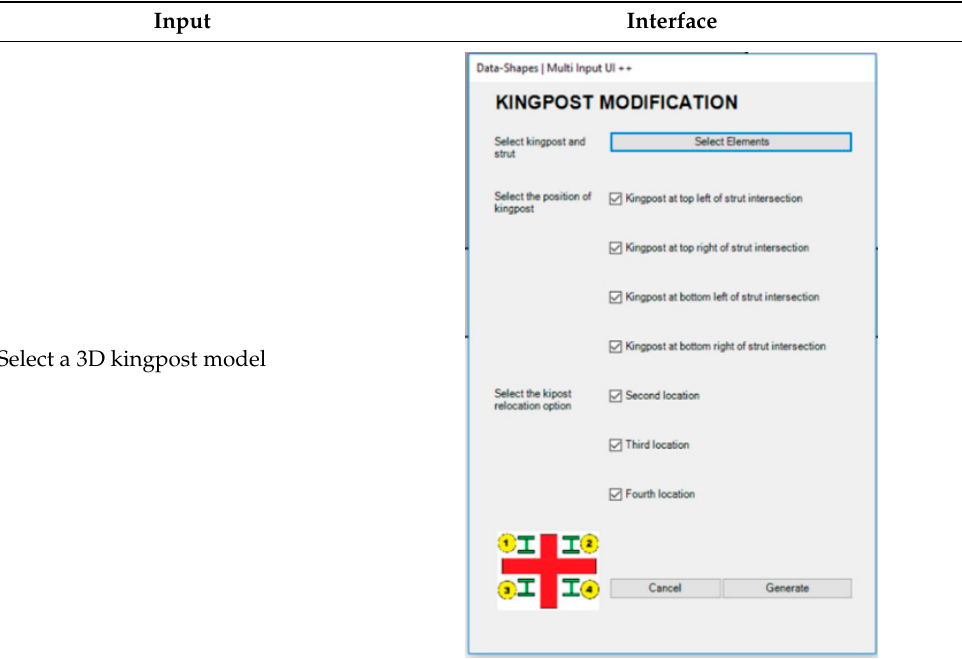
Table 9. The input and interface of kingpost relocation.